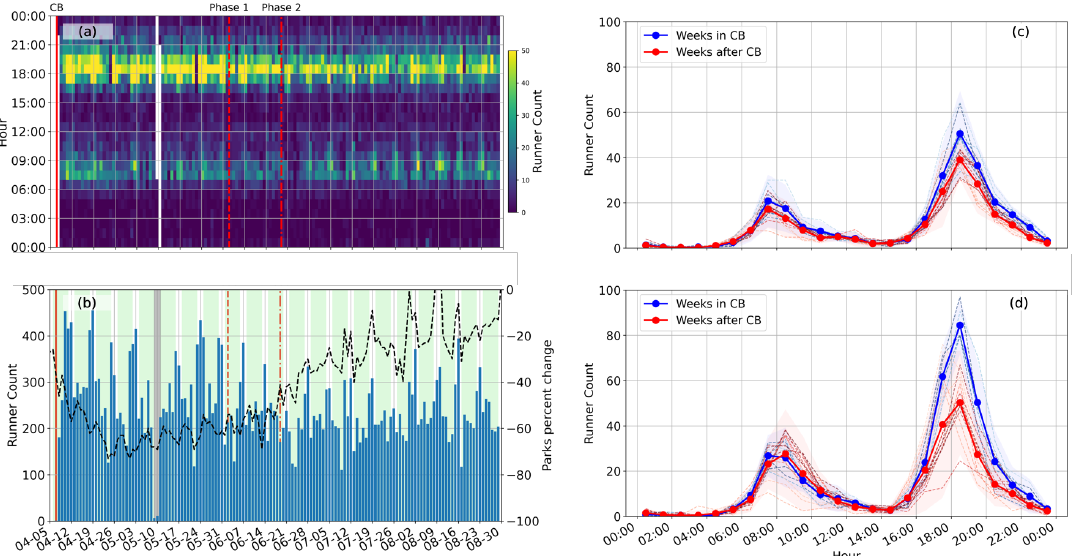
Figure 8. Runner count detected by the seismometer at West Coast Park. ( a ) Hourly runner count on each calendar day. ( b ) Daily runner count on each calendar day. In ( c , d ), runner counts are plotted with blue and red colors to denote the periods during and after the lockdown, respectively. The thick solid lines denote the average runner count over all the weeks during (blue) and after (red) the lockdown, and the thin dashed lines denote the weekly averages. The darker dashed line denotes a later week than a lighter dashed line. The shaded area covers the range of twice the standard deviations above and below the mean. In ( c ), hourly runner counts are shown for the weekdays. In ( d ), hourly runner counts are shown for the